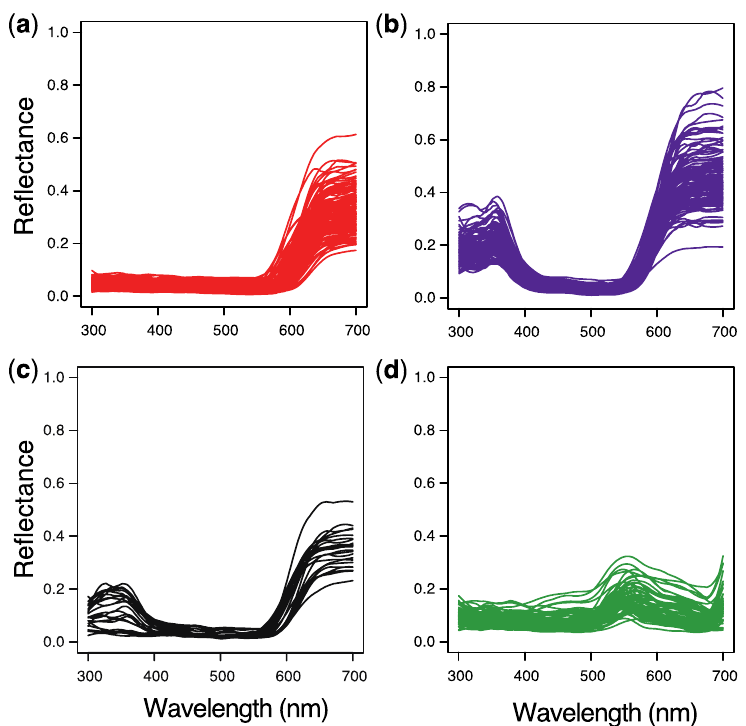
Figure 3. Reflectance spectra of flowers and foliage of P. rhoeas collected in the field and measured with a spectrometer setup with two optical fibers. ( a ) Reflectance spectra of flowers collected in the East Mediterranean (n = 124). ( b ) Reflectance spectra of flowers collected in Central Europe (n = 116). ( c ) Reflectance spectra of flowers collected in the North Mediterranean (n = 22). ( d ) Reflectance spectra of green foliage (n = 77).